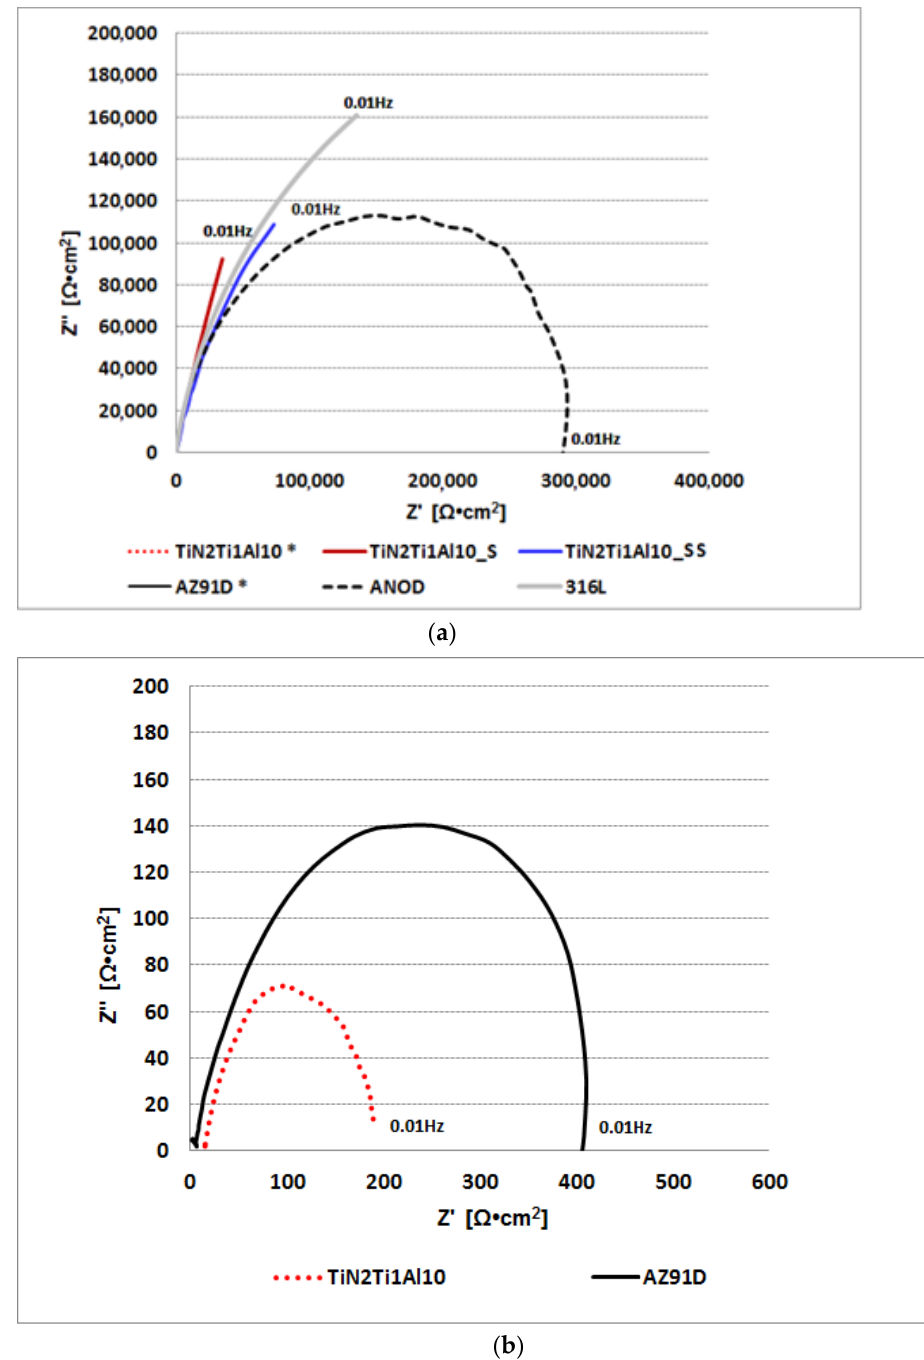
Figure 7. Impedance spectroscopy results obtained for the AZ91D alloy covered with various composite TiN-Ti-Al titanium nitride surface layers in the as-deposited (TiN2Ti1Al10) and sealed (TiN2Ti1Al10_S TiN2Ti1Al10_SS) variants and, for comparison, the untreated (AZ91D), anodized AZ91D alloy (ANOD) and 316L stainless steel (316L) Nyquist plots: (a) general view; (b) magnifi- cation for low impedance variants curves, not visible in Figure 7a: TiN2Ti1Al10* and AZ91D*. Table 4. Values of corrosion parameters in potentiodynamic tests (Figure 6): corrosion potential, E cor ; current density — I cor ; breakdown potential — E np ; current density — I np.